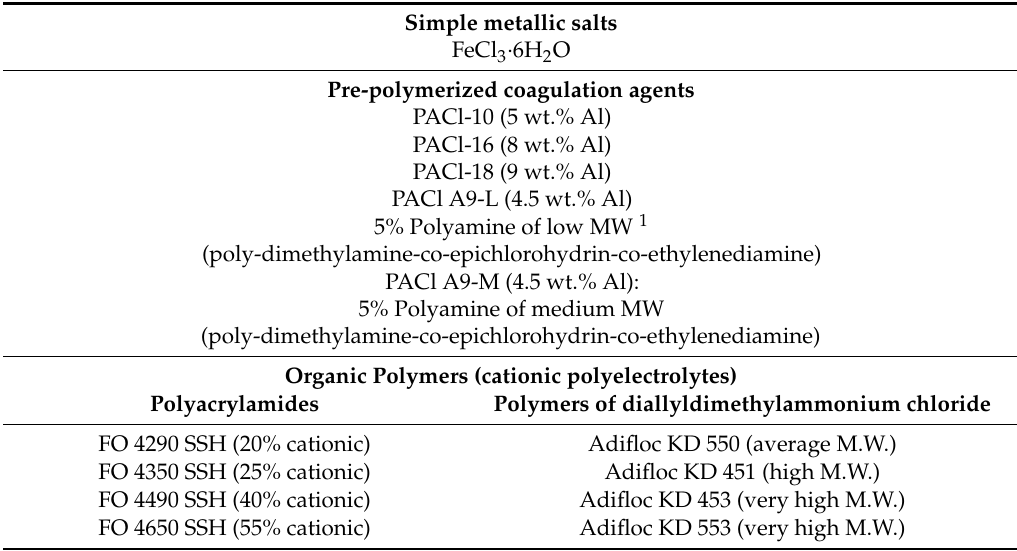
Table 2. Coagulation / flocculation agents used in the present